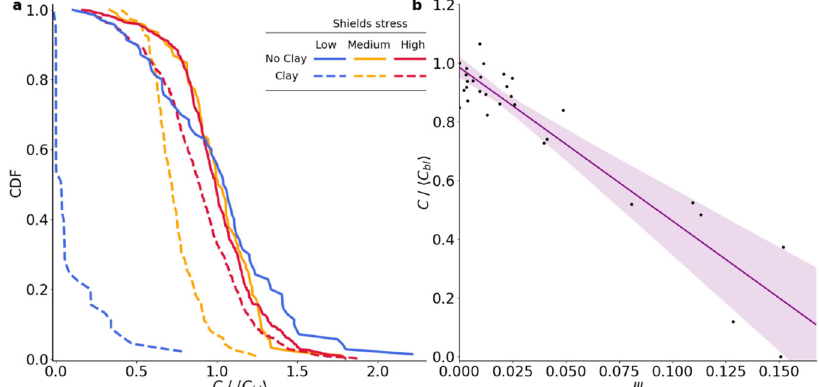
Fig. 2 Interplay between Shields stress, clay deposition, and bedform morphodynamics. a Three examples of distributions of bedform celerity prior to (solid) and following (dashed) clay addition for low (blue), medium (yellow), and high (red) Shields stresses. The bedform celerity distribution decreases following clay deposition, and the reduction is more pronounced under smaller imposed fl uid shear (blue lines). b Normalized bedform celerity decreases with the bedform stabilization ratio ψ ¼ M τ , indicating that the observed morphodynamic changes re fl ect a balance between cohesive forces and the fl uid (cid:1) Shields stress. Points represent the average of the 100 h of bedform celerity data. Linear fi t (R 2 = 0.93) with 95% con fi dence interval is shown. This relationship is consistent for both locking (stabilization dominated) and segregating (mobilization dominated) conditions.